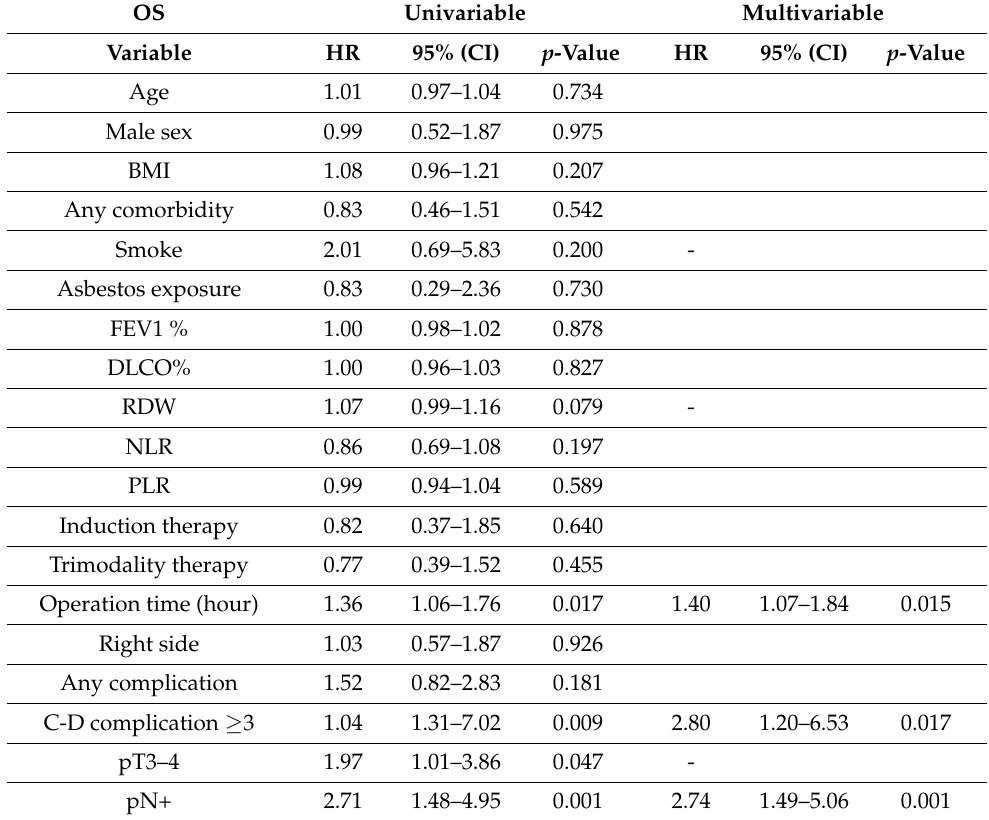
Table 4. Details of the statistical analysis: univariate and multivariate analyses—overall survival (Cox proportional hazards model).